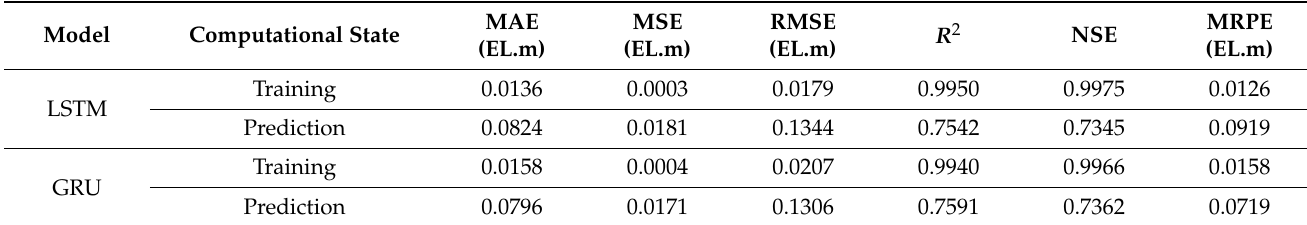
Table 8. Comparison of univariate model performance.